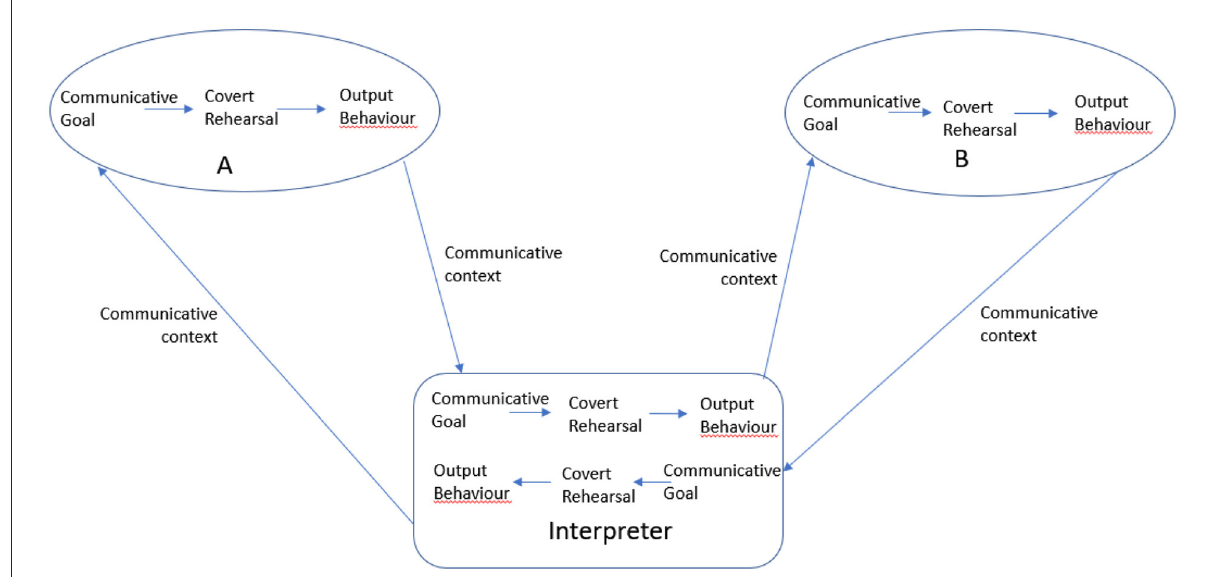
FIGURE1 Interpersonal feedback loop of the symbolic interactionist model of interpreter-facilitated communication.